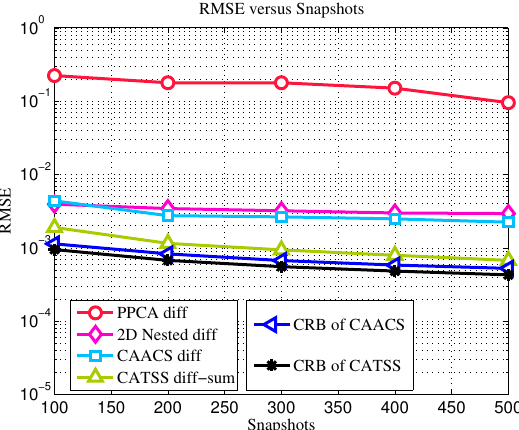
Figure 12. RMSE as a function of snapshots for different array configurations with M 1 = 9, M 2 = 5, p = 3, l = 32. The SNR is 0 dB, and the pseudo snapshots satisfy K p = K